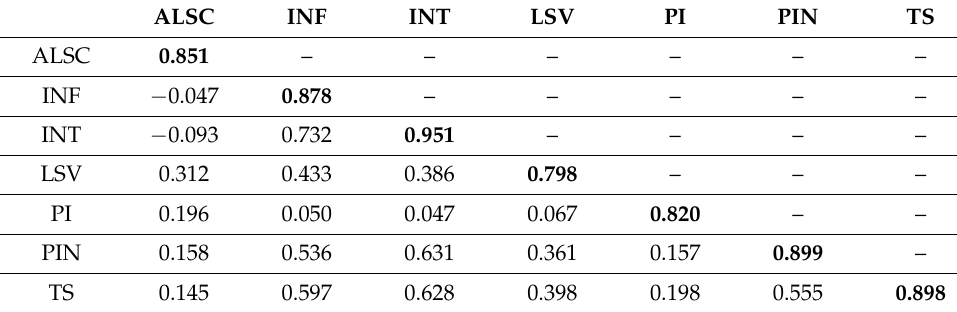
Table 6. Results of correlation analysis and discriminant validity